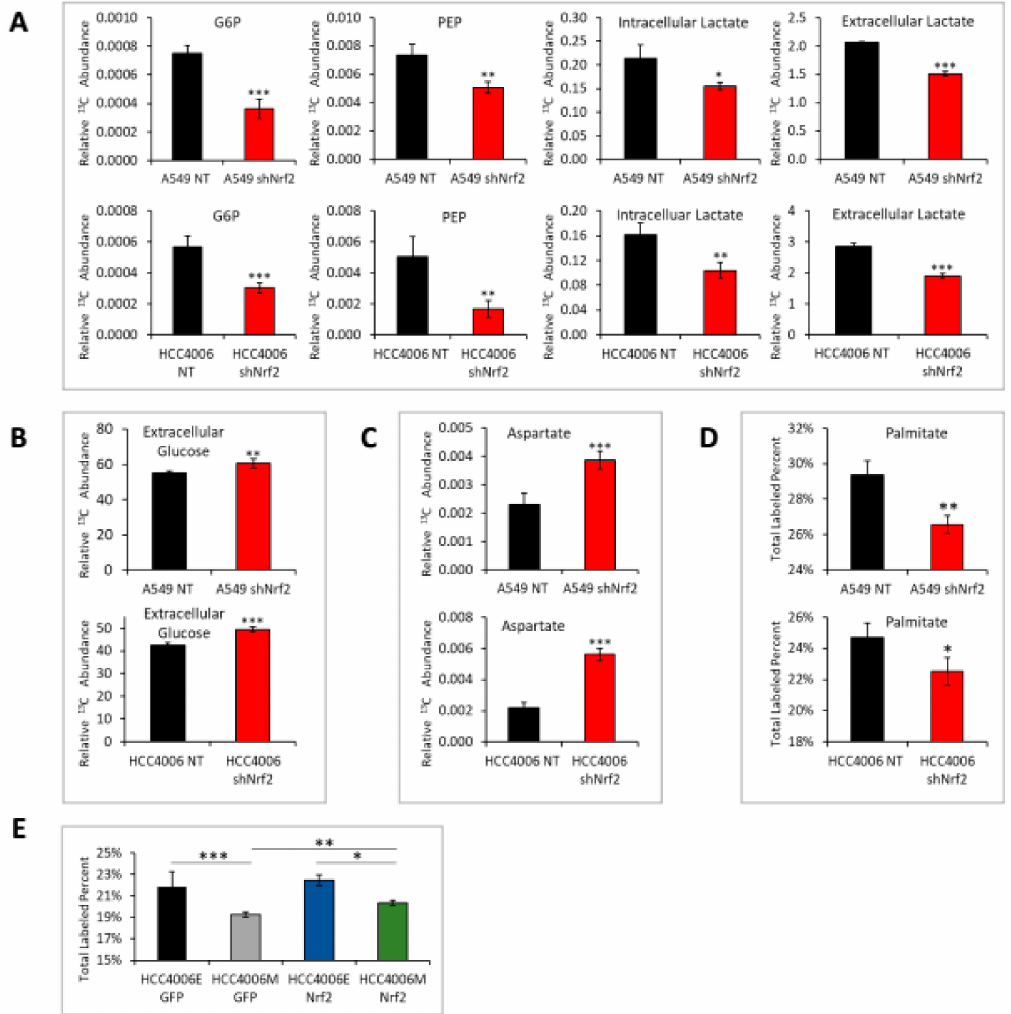
Figure 6. Knockdown of Nrf2 phenocopies mesenchymal state metabolic alterations. ( A ) In HCC4006 and A549 with Nrf2 knockdown treated with 13C glucose; production of G6P, PEP, intracellular lactate, and extracellular lactate are reduced ( p < 0.05 *; p < 0.01 **; p < 0.001 ***). ( B ) Nrf2 knockdown cells have increased extracellular glucose. ( C ) Nrf2 knockdown increases aspartate. ( D ) With Nrf2 knockdown, incorporation of 13C6-glucose into palmitate is attenuated. Isotopologue distributions are shown in Supplementary Figure S5. ( E ) Conversely, when Nrf2 is overexpressed in HCC4006, incorporation of 13C6-glucose into palmitate is increased (GFP control vs. Nrf2; p <